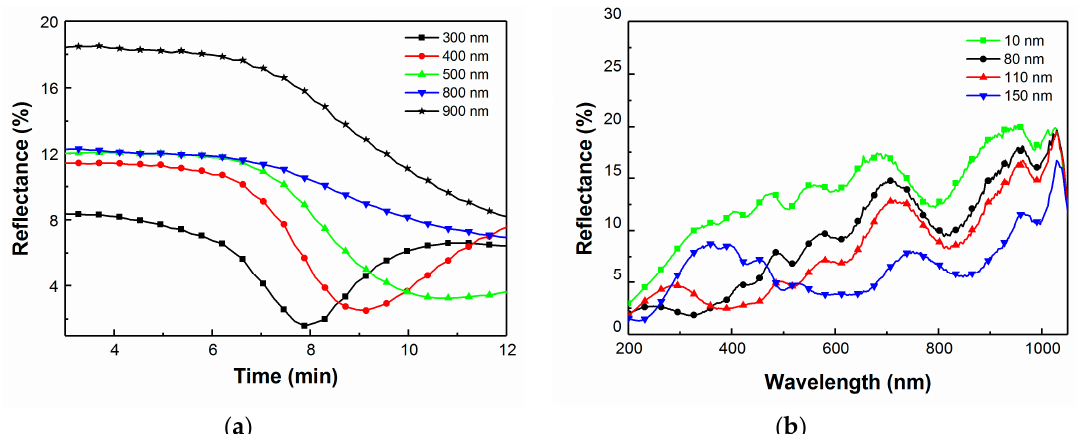
Figure 5. ( a ) Real-time variation of the reflectance during the course of deposition of the AR layer ( t = 3 to 12 min). ( b ) Real-time variation of the reflectance of the CIGS structure with increased thickness of the AR layer.